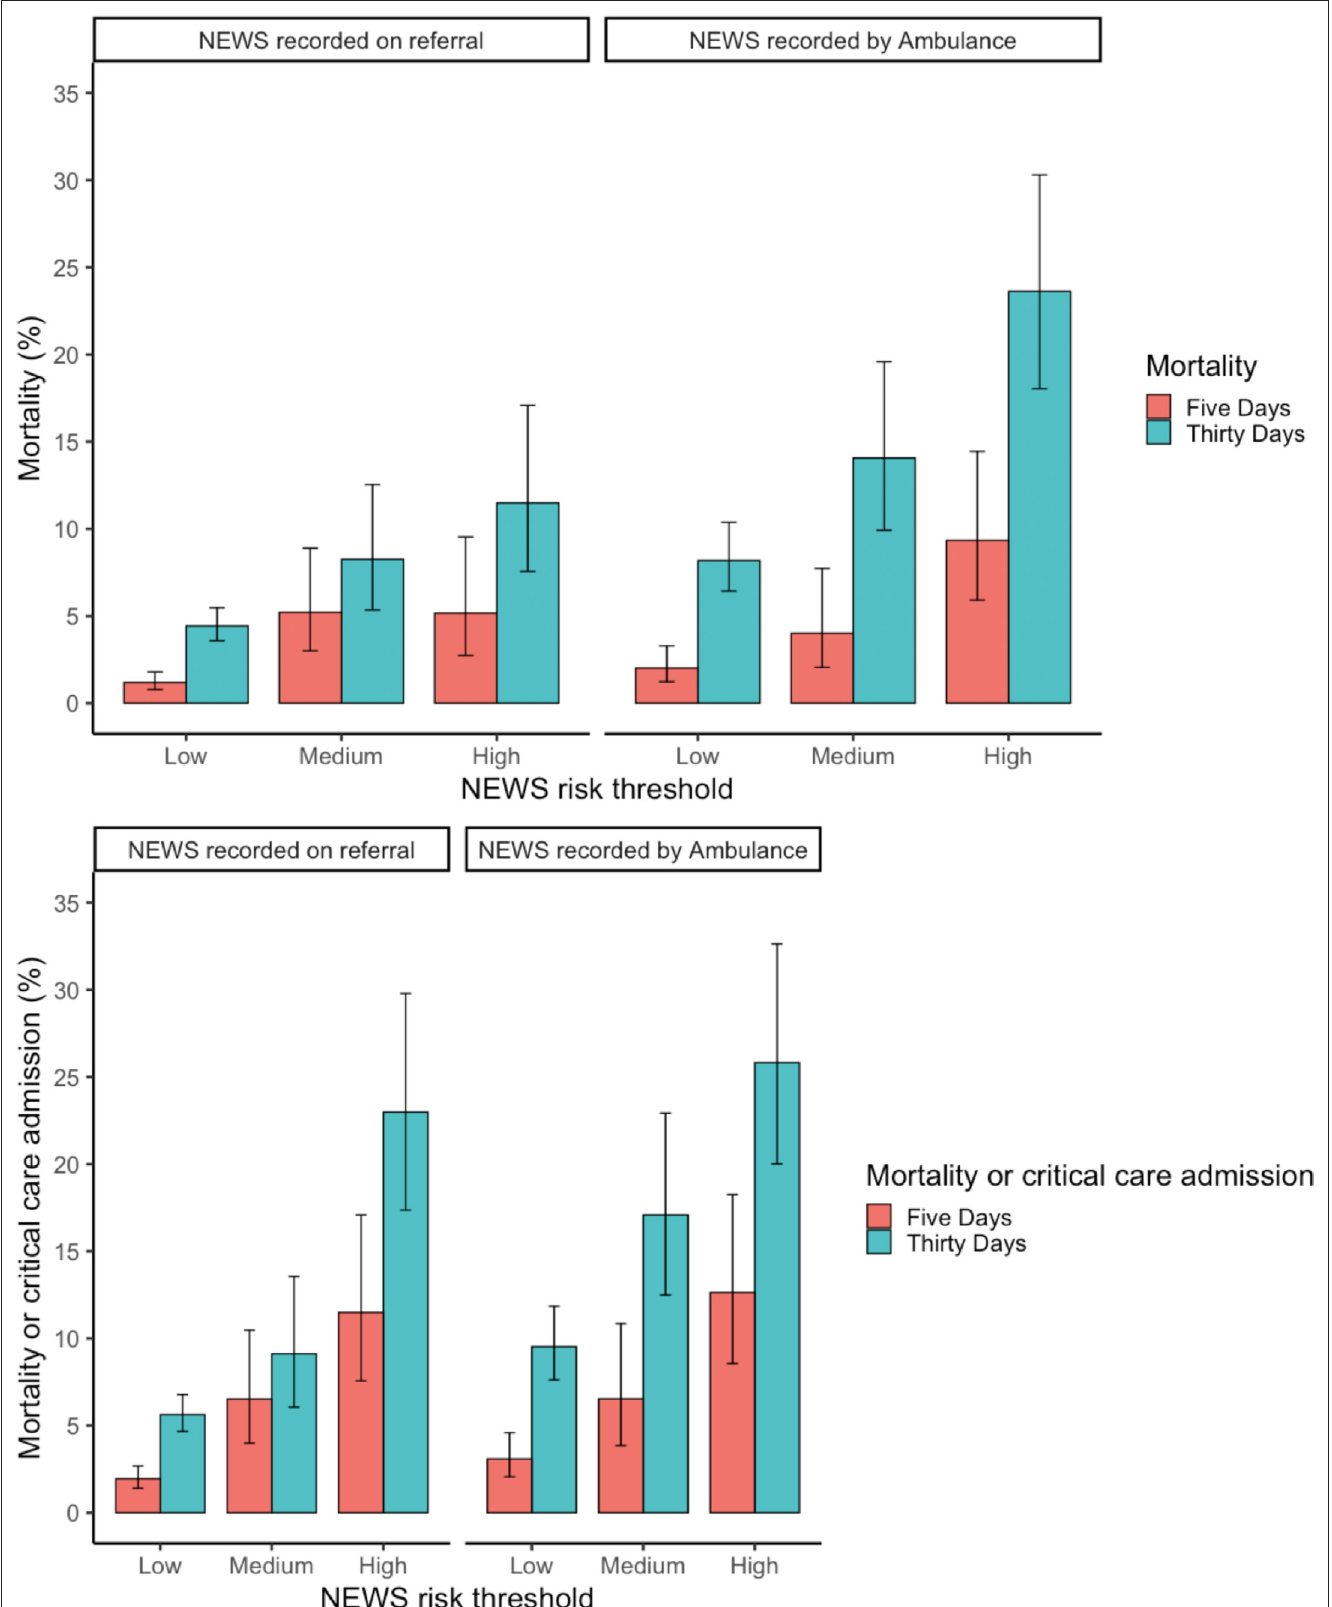
Figure 3 Adverse outcomes stratified by source of NEWS and risk